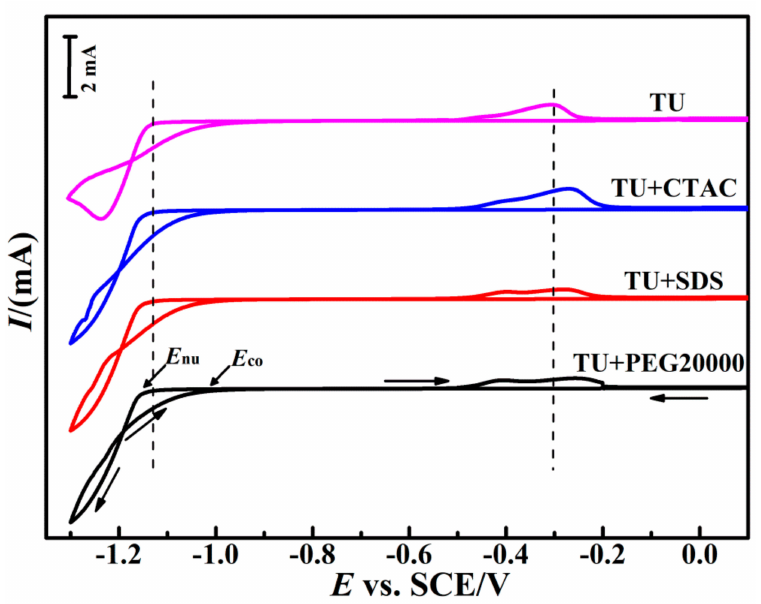
Figure 2. Cyclic voltammetry curves for nickel electrodeposition from ammoniacal solutions by containing composite